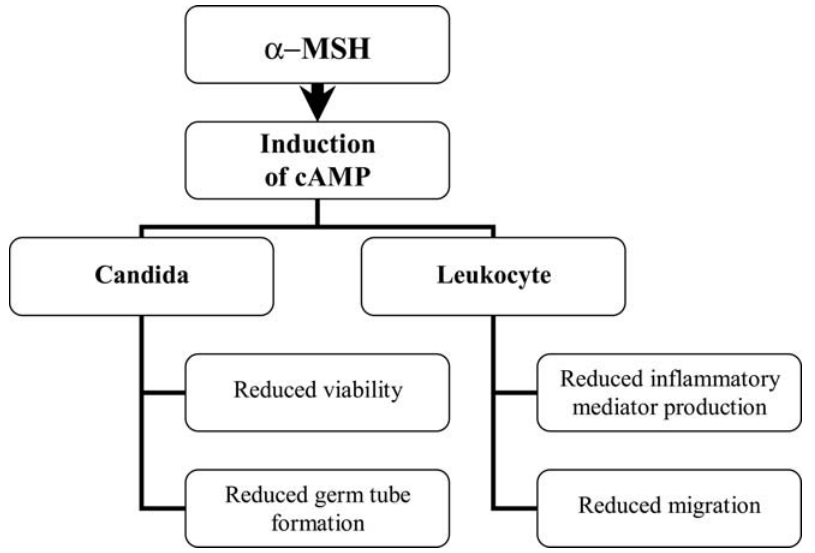
FIGURE 1. The candidacidal influences of α -MSH are exerted through induction of cAMP. Because cAMP-activated pathways are of paramount importance for gene expression in C. albicans , the strong cAMP-inducing capacity of α -MSH likely interferes with the yeast’s own regulatory mechanisms of this essential signaling pathway. This mechanism mimics influences of the peptide in leukocytes and other cells in which α -MSH increases cAMP and modulates gene